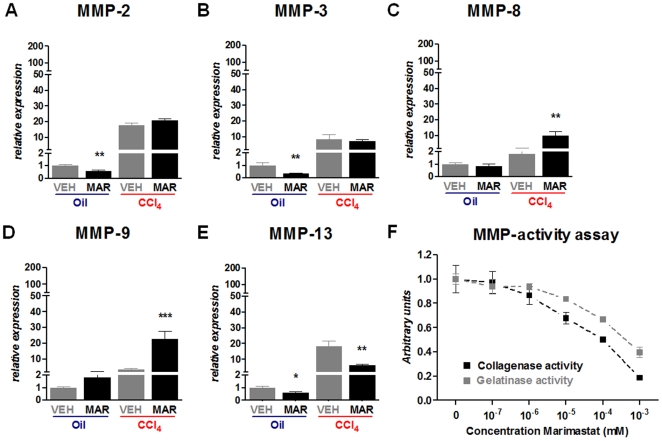
Marimastat treatment downregulates matrix metalloproteinase (MMP) gene expression and MMP-activities.Following repeated carbon tetrachloride (CCl4) administration, Marimastat did not affect hepatic transcript levels of MMP-2 (A), or MMP-3 (B) as quantified by real-time RT-PCR. Hepatic MMP-8 (C) and MMP-9 (D) transcripts were significantly upregulated in livers from Marimastat treated animals, whereas hepatic MMP-13 mRNA was significantly higher in the vehicle treated animals (E). Marimastat inhibits interstitial collagenolytic and gelatinolytic activity in a dose-dependent matter (F). Relative gelatinase and interstitial collagenase activities after 4 hours in liver homogenates supplemented with increasing concentrations of Marimastat, as determined by degradation of DQ-gelatin and collagen (black and grey squares, respectively). Oil, non-fibrotic control group; CCl4, fibrotic mice; VEH, vehicle treated control group; MAR, Marimastat treated experimental group; TNF, tumor necrosis factor; MMP, matrix metalloproteinase; *, P<0.05; **, P<0.01; ***, P<0.001 vs. vehicle alone. Data are expressed as means ± standard error and in arbitrary units.